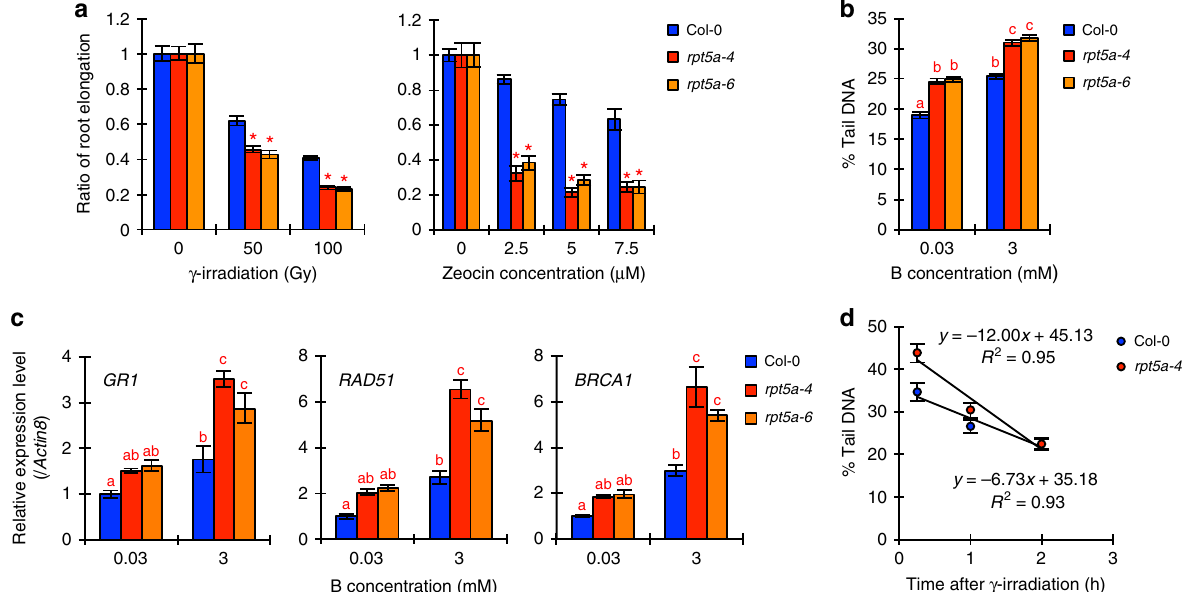
Fig. 4 RPT5a functions in reducing DSB induction by high-B stress rather than in DSB repair. a Sensitivity of root growth to different types of DSB-inducing factors: γ -irradiation and zeocin. Values are ratios relative to the values under each normal condition ( n = 18 – 22, average ± s.e.m.; * P < 0.05, compared with Col-0, Student ’ s t -test). b Levels of DSBs in root tips of Col-0 and rpt5a mutant plants grown under normal- and high-B conditions ( n = 125 – 132 nuclei, average ± s.e.m.; P < 0.05, one-way ANOVA and Tukey ’ s HSD). c Expression levels of DSB-inducible genes in root tips of Col-0 and rpt5a mutant plants grown under normal- and high-B conditions ( n = 4, average ± s.e.m.; P < 0.05, one-way ANOVA and Tukey ’ s HSD). d DSB repair rate in Col-0 and rpt5a-4 root tips after transient DSB induction by γ -irradiation, represented using data from Supplementary Fig. 8